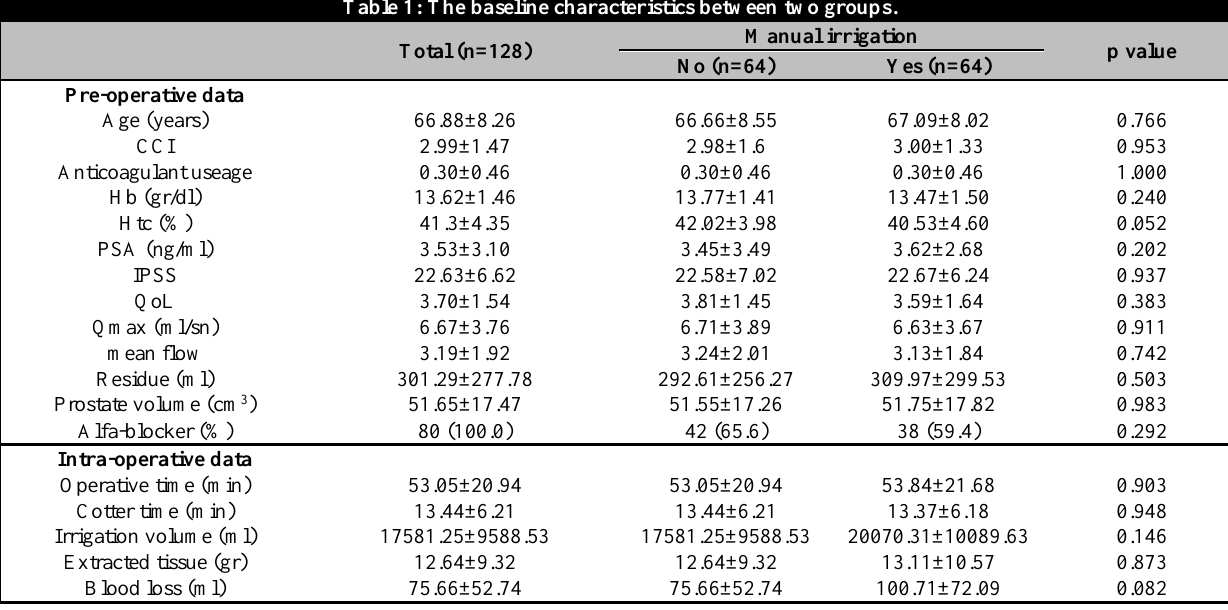
Table 1: The baseline characteristics between two